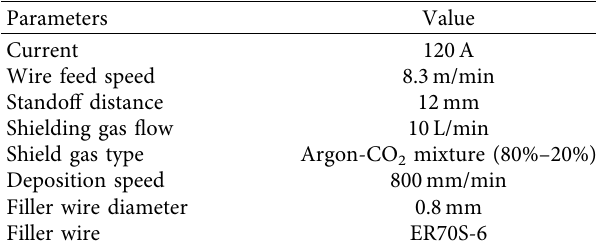
Table 1: Set values of process